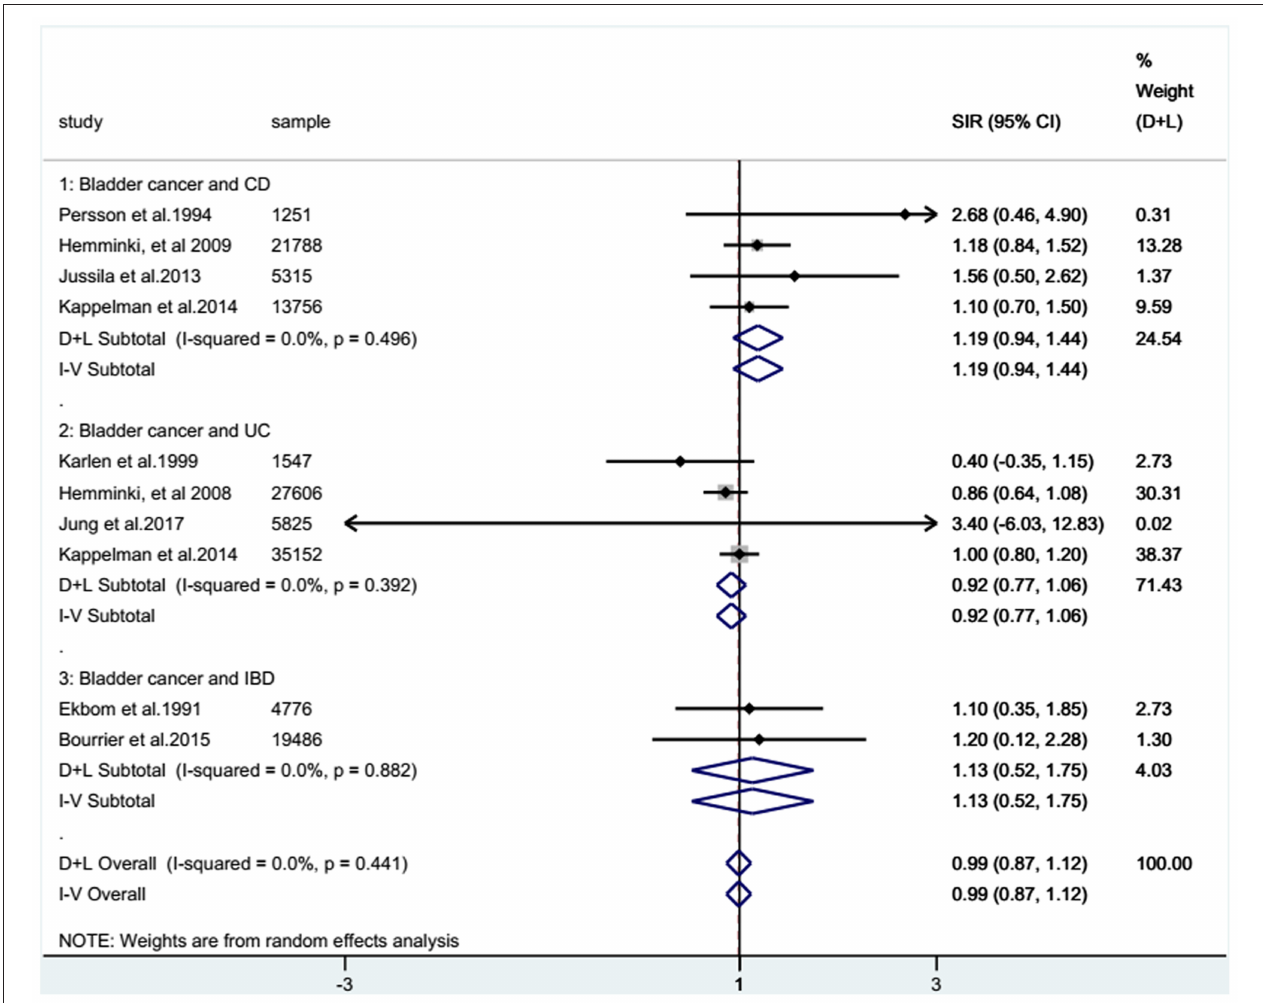
FIGURE 2 | Combined standardized incidence ratios (SIRs) of all eligible cohort studies. Forest plots showing the combined SIRs with 95% confidence intervals for bladder cancer occurrence in inflammatory bowel disease patients, based on eligible population-based cohort studies. The size of the black boxes is proportional to the weight of the corresponding